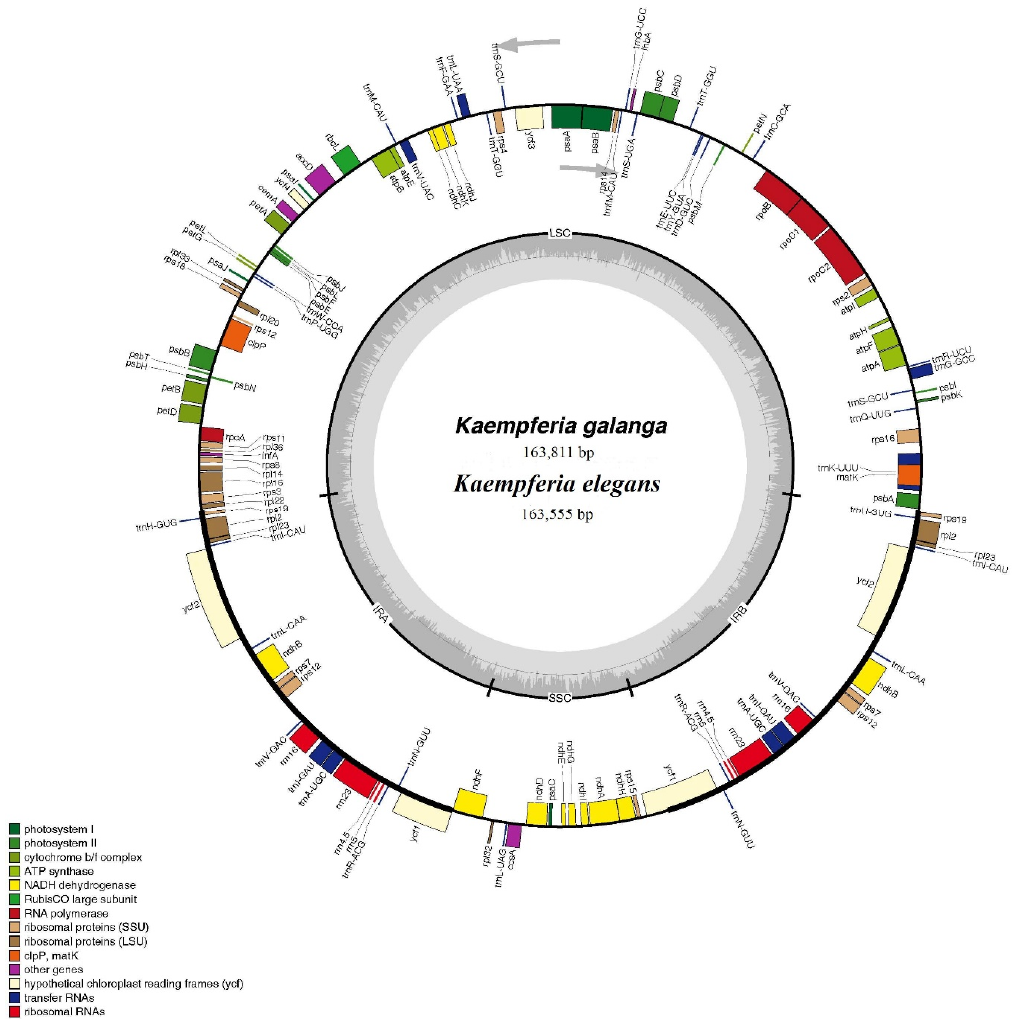
Figure 1. Circular gene map of chloroplast genomes of two Kaempferia species. The gray arrowheads indicate the direction of the genes. Genes shown inside the circle are transcribed clockwise and those outside are transcribed counterclockwise. Different genes are color coded. The innermost darker gray corresponds to GC content, whereas the lighter gray corresponds to AT content. IR, inverted repeat; LSC, large single copy region; SSC, small single copy region.